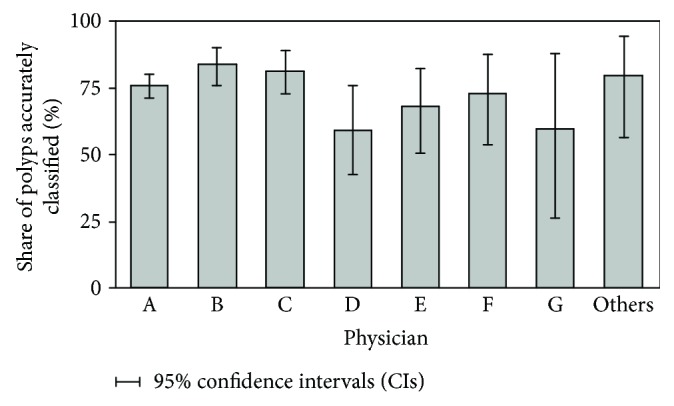
Diagnostic accuracy over different physicians along with the 95% confidence intervals.